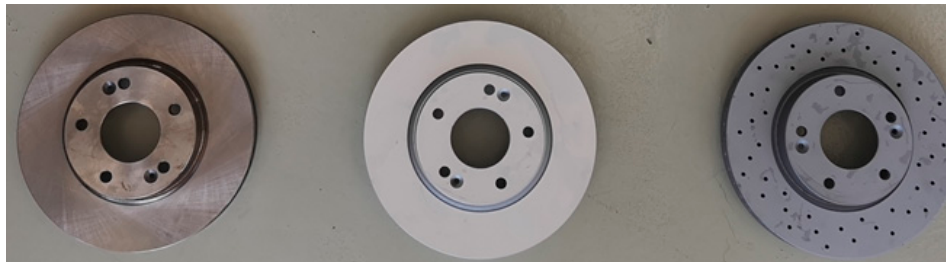
Figure 1. Low-priced, mid-priced and high-priced brake discs selected for measuring.